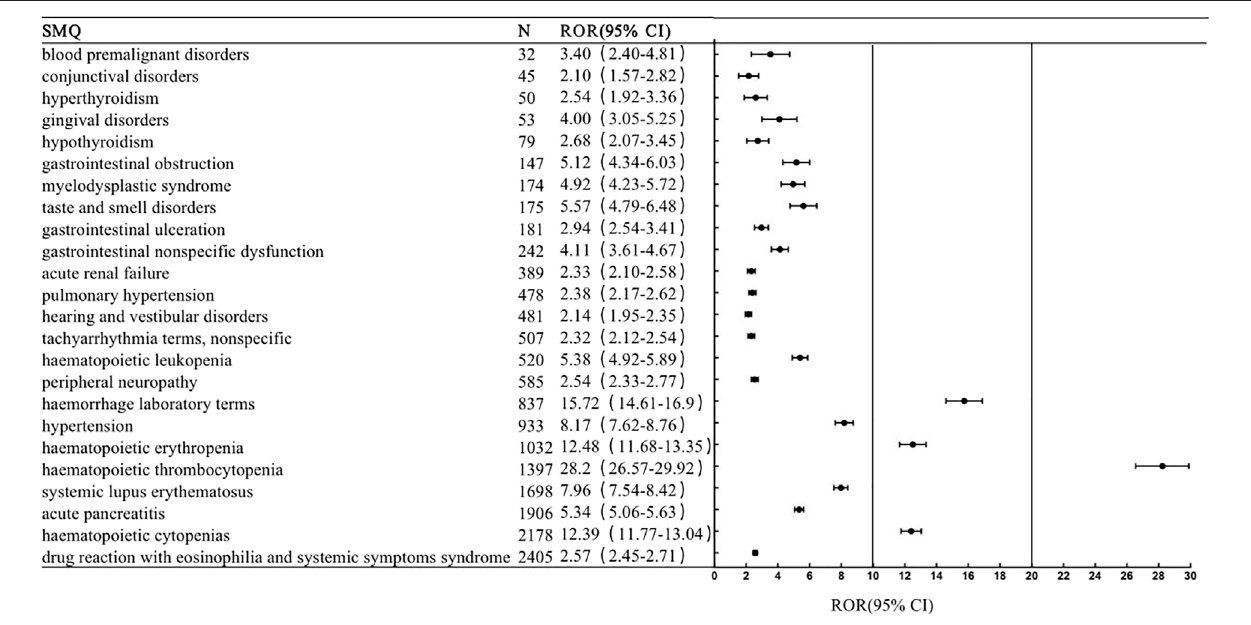
FIGURE 3 | The positive signal distribution of Niraparib using standardized MedDRA queries.